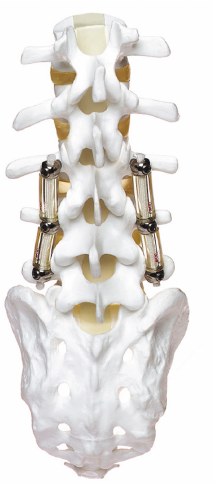
Figure 2: Dynesys device applied on a spinal